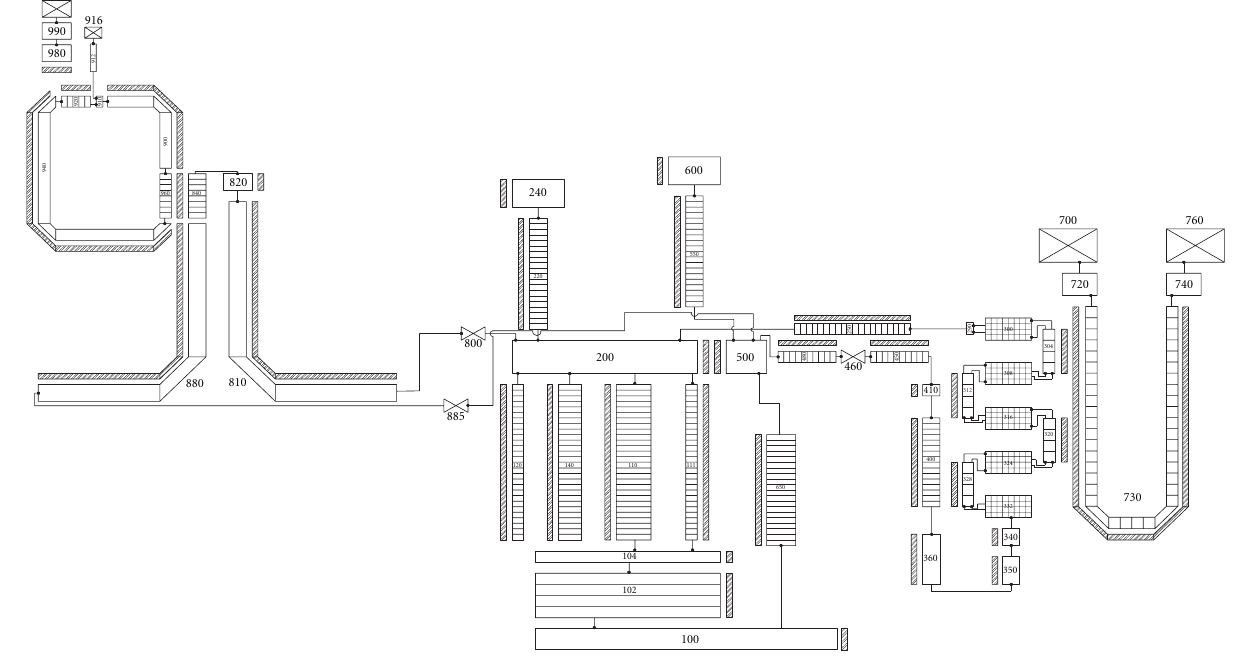
Figure 4: RELAP5-3D ETDR nodalization [10].